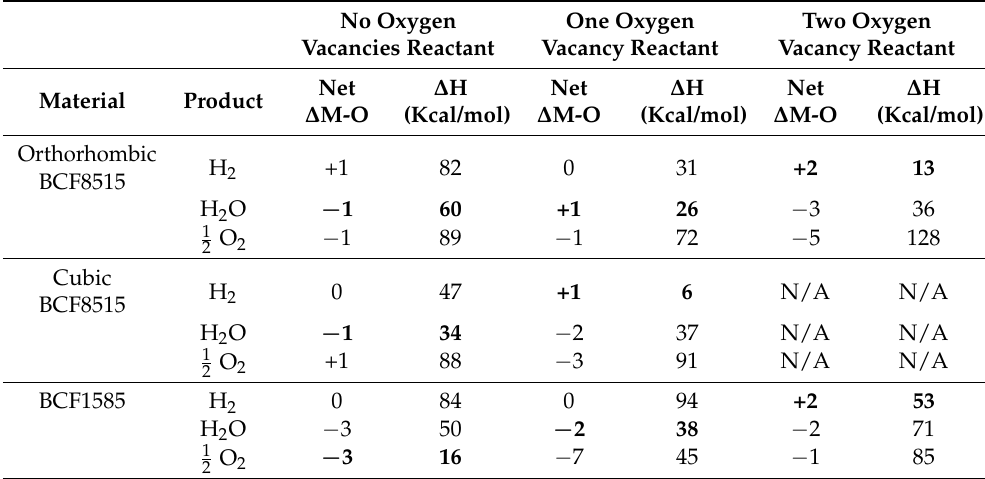
Table 1. Enthalpy change and net metal coordination change for each reaction. Bold values indicate the dominant